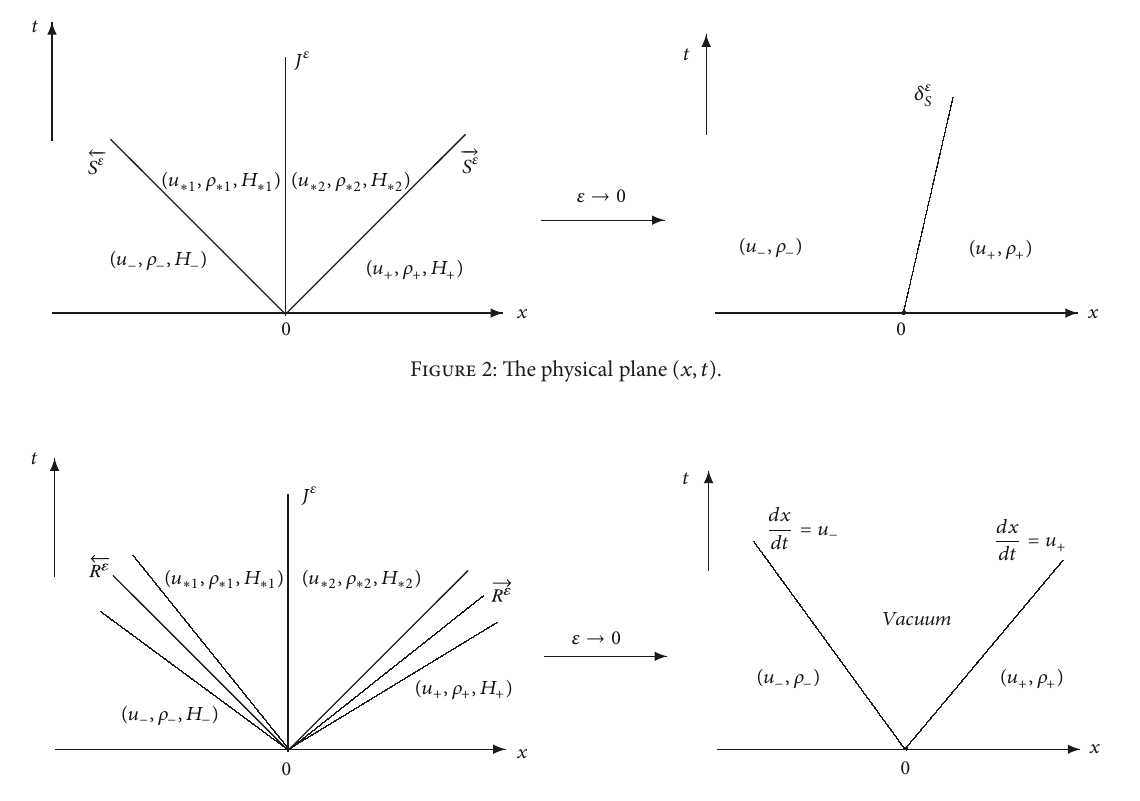
Figure 3: The physical plane (𝑥,𝑡)